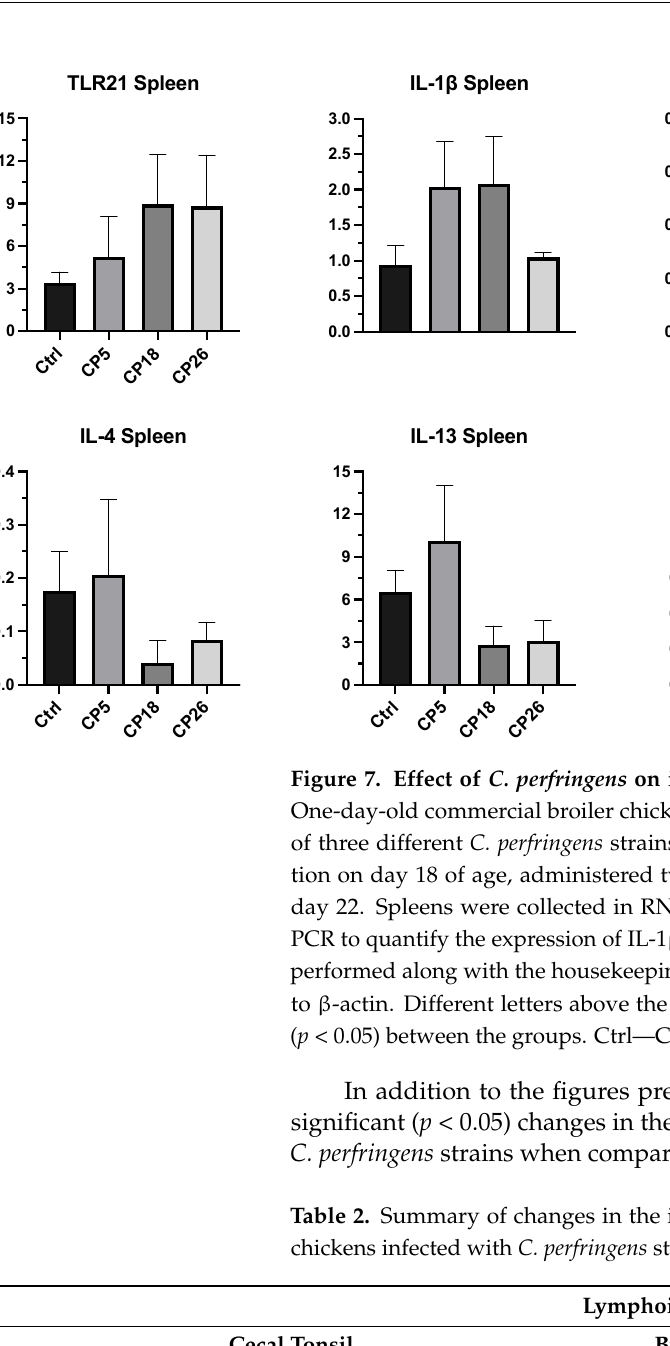
Table 2. Summary of changes in the immune system gene expression in the lymphoid tissues of chickens infected with C. perfringens strains compared to uninfected control group.